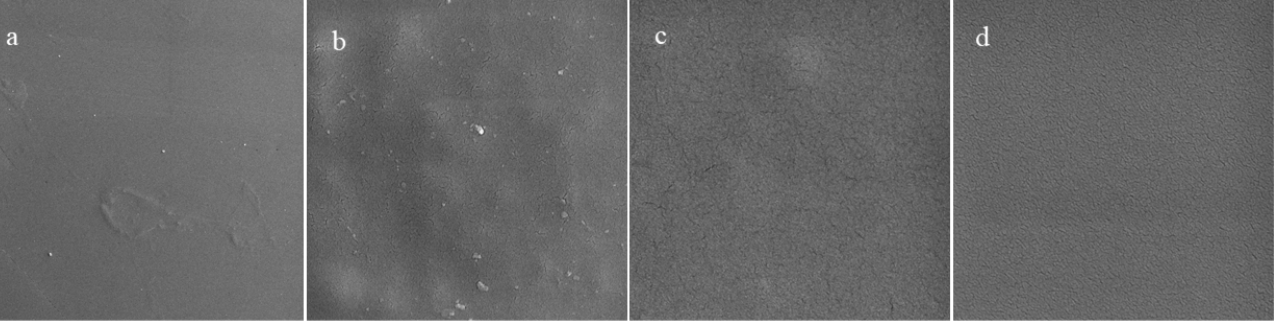
Figure 4. FE-SEM image of ( a ) gelatin, ( b ) gelatin/chitosan nanofibers, ( c ) G/CsNFs/Bas, and ( d ) G/CsNFs/SPAs films. ( d ) G/CsNFs/SPAs